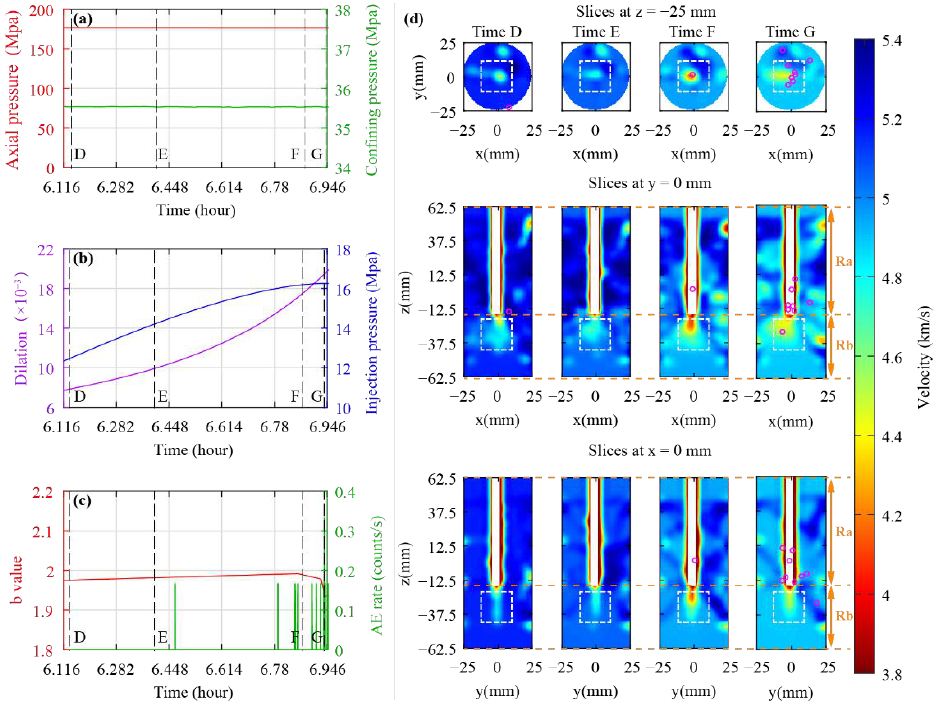
Figure 10. Mechanical response and velocity images of rock before water injection pressure reached peak value in H1 phase: ( a ) axial (red line) and confining pressure (green line); ( b ) dilation (purple line) and water injection pressure (blue line); ( c ) b-value (red line) and AE rate (green line); ( d ) slices of the 3D ultrasonic velocity images at different times (Times D~G, respectively, correspond to the times marked by the black dotted lines in the left subfigures, and the magenta circles represent the positions of acoustic emission events occurring before the corresponding times). The orange dotted line in the subfigure ( d ) represents the boundary between region Ra and Rb. The white dotted line box represents the low-velocity zone below the borehole.